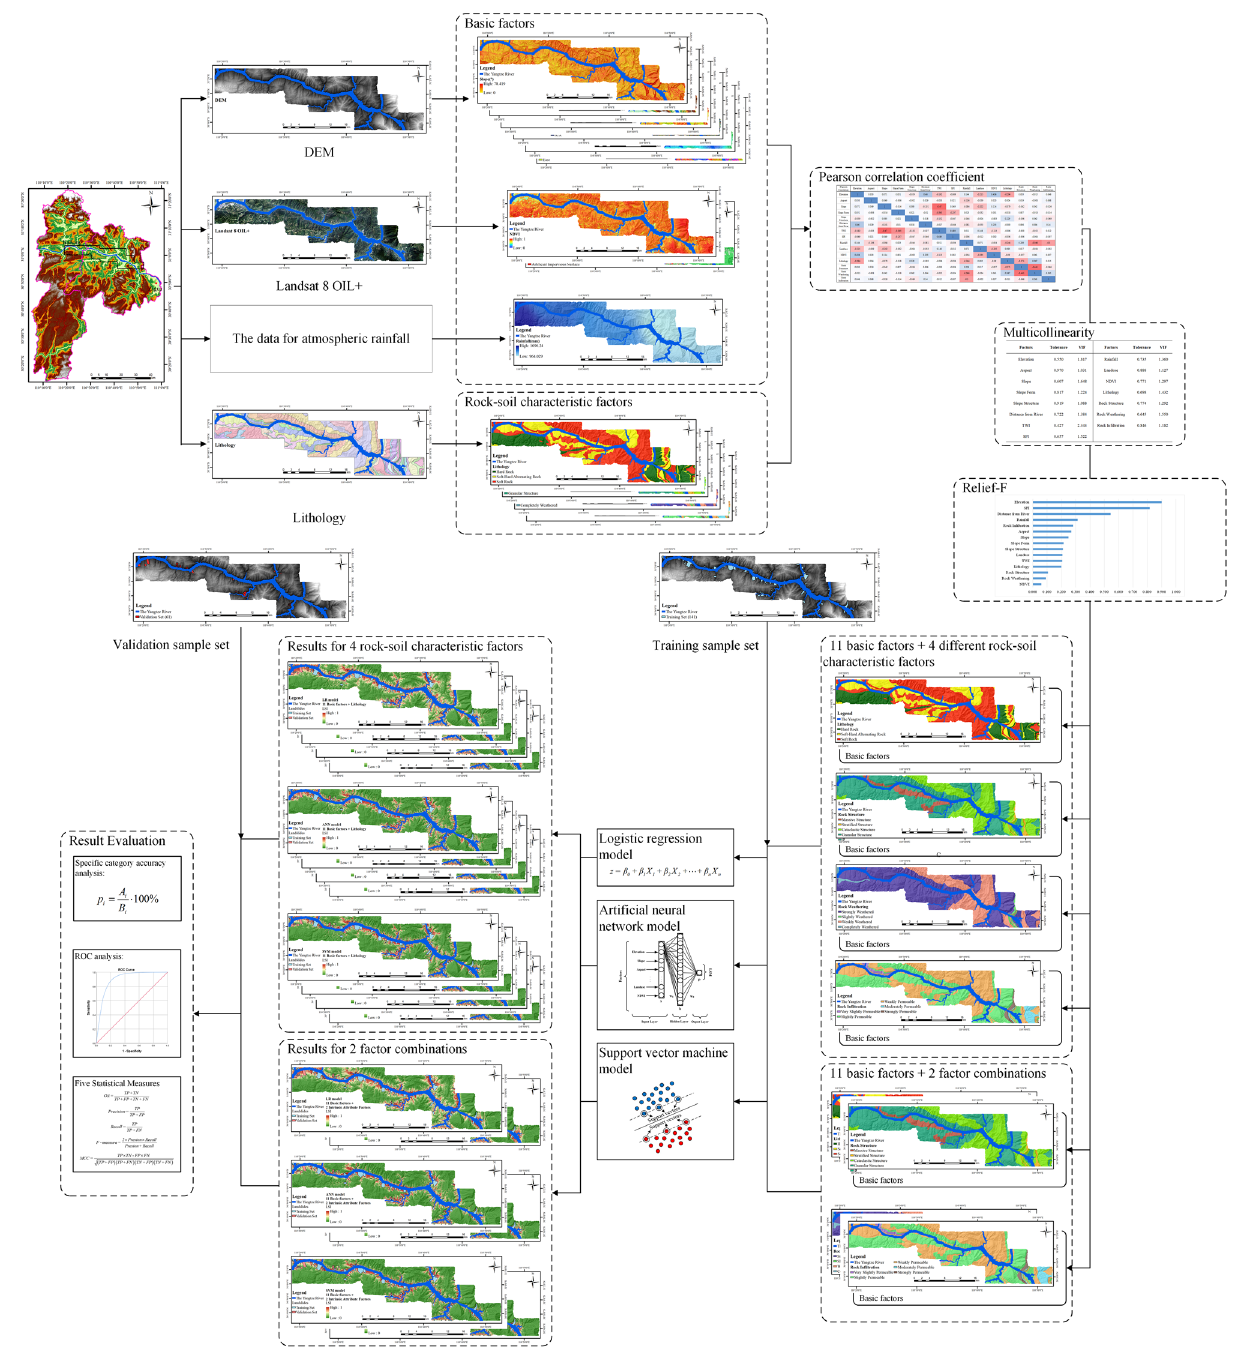
Figure 10. Flow chart of this